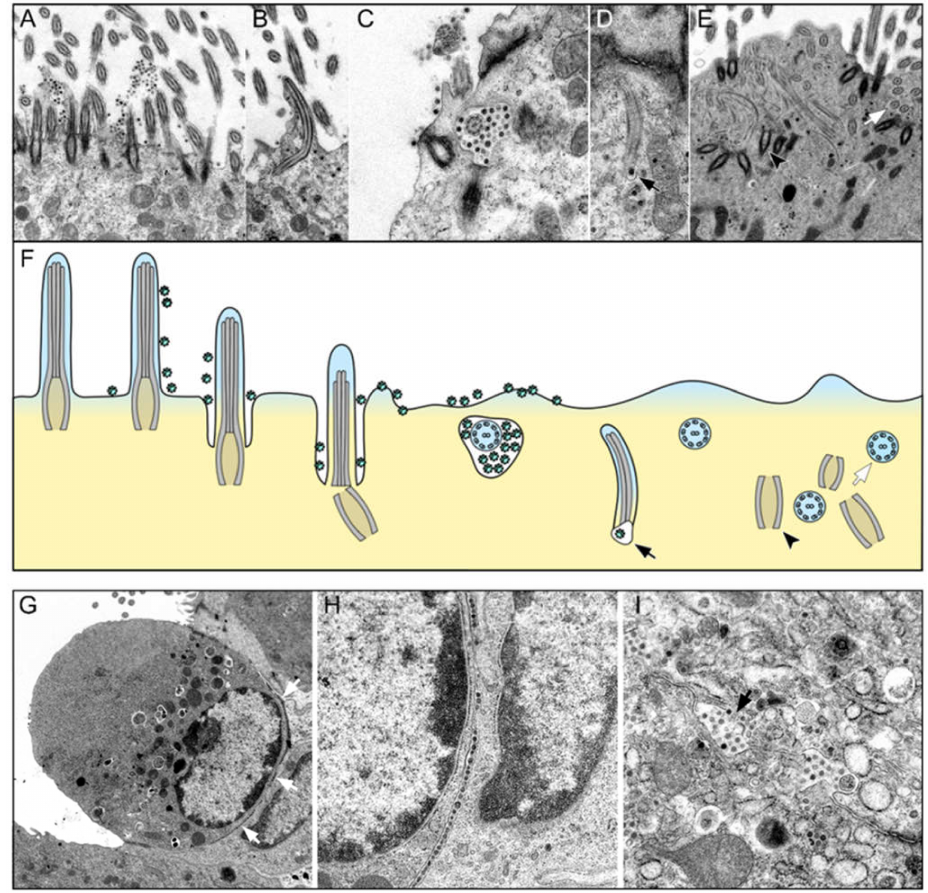
Figure 3. Cilia retraction and virus entry and spread in the tracheal epithelium of SARS-CoV-infected hamsters at 1 day post infection (dpi). ( A – F ) Representative transmission electron micrographs showing different stages of ciliary retraction and a schematic illustration of the proposed sequence of cilia internalization and SARS-CoV-2 entry into the cell. ( A ) Numerous virions are attached to the cilia and the microvilli surface. ( B ) Retraction of an entire cilium into the cytoplasm. Virus particles are in close contact with the retracted axoneme. ( C ) Cross-section of a completely internalized ciliary axoneme surrounded by virus particles and an infolding of the plasma membrane. ( D ) Internalized cilium with an associated virus particle located in a vacuole (arrow in ( D , F )). ( E ) Numerous separated axonemes (white arrows in ( E , F )) and basal bodies (black arrowheads in ( E , F )) within the cytoplasm. Magnifications are 12,500 × in ( A,B ), 31,500 × in ( C , D ), and 10,000 × in ( E ). ( F ) Schematic illustration of proposed sequence of cilia internalization and SARS-CoV-2 entry into the cell. ( G – I ) Virus spread between adjacent cells in the trachea of a SARS-CoV-2-infected hamster at 1 dpi. ( G ) SARS-CoV-2- infected epithelial cell with virus particles aligned along the basal cell pole (white arrows). ( H ) Higher magnification of G showing the basal cell pole. Virus particles lined up at the intercellular space and in the cytoplasm of the underlying cell. ( I ) Virus spreading from the intercellular space into a neighboring cell (arrow). Magnifications: 6300 × in ( G ), 16,000 × in ( H ), and 12,500 × in ( I